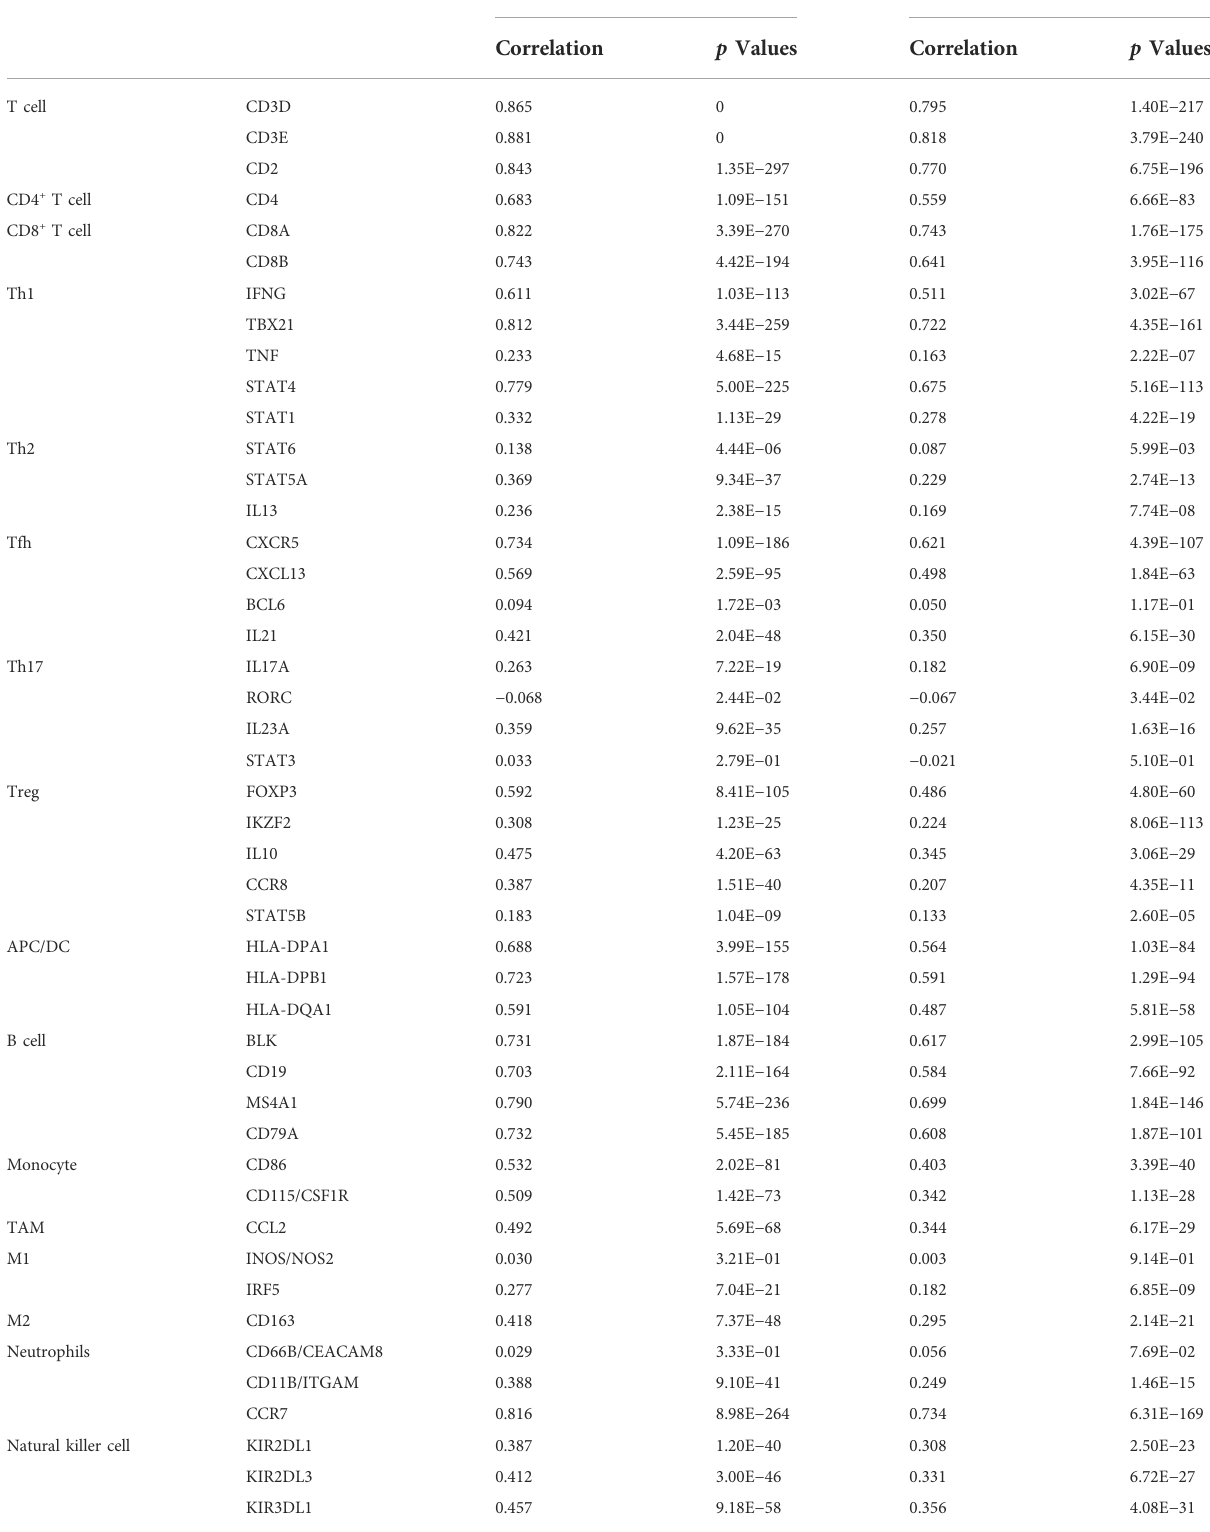
TABLE 3 Correlation analysis between CD161 and gene markers of immune cells by